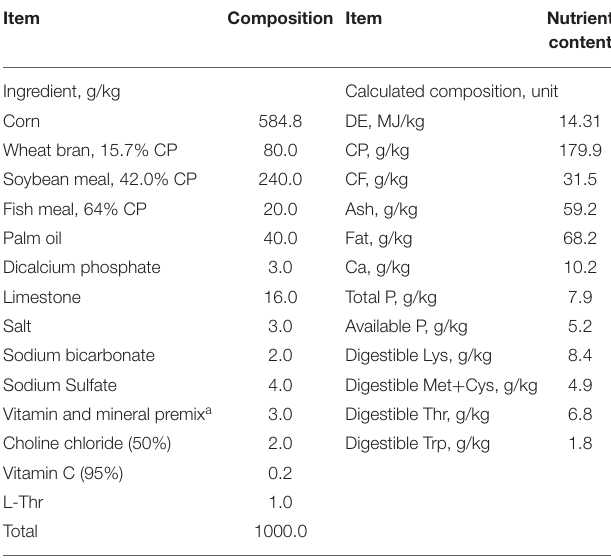
TABLE 2 | Composition and nutrient content of basal diets (as-fed